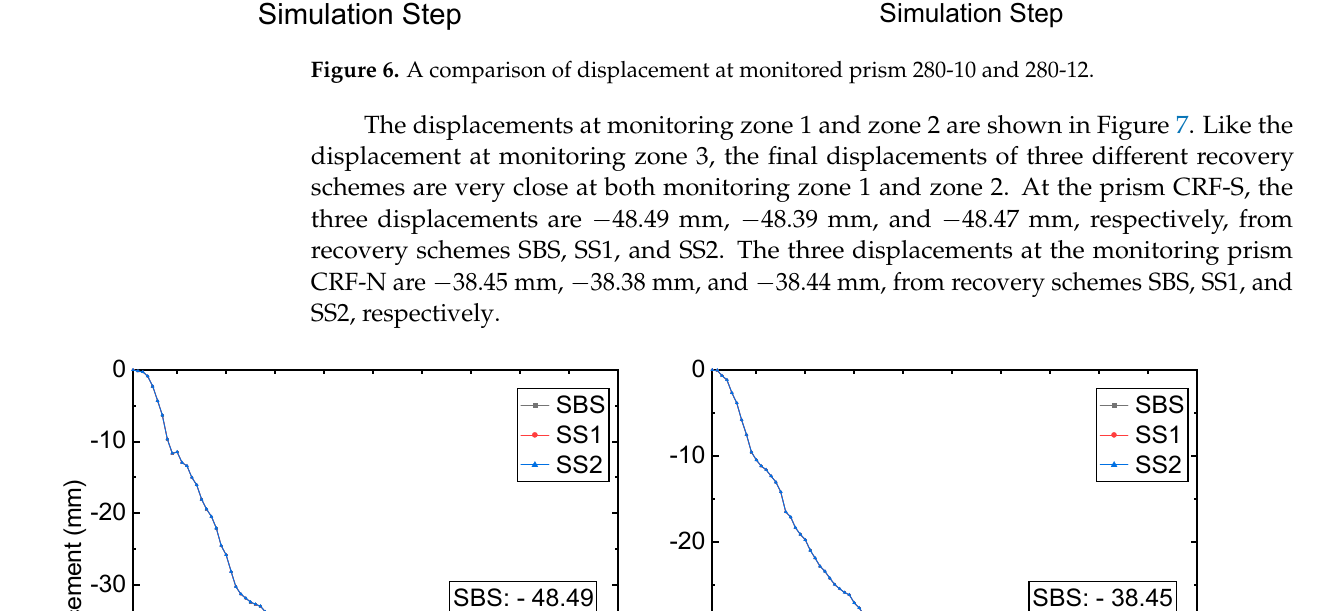
Figure 7. A comparison of the displacement at monitored sites S01-02 and N01-02.